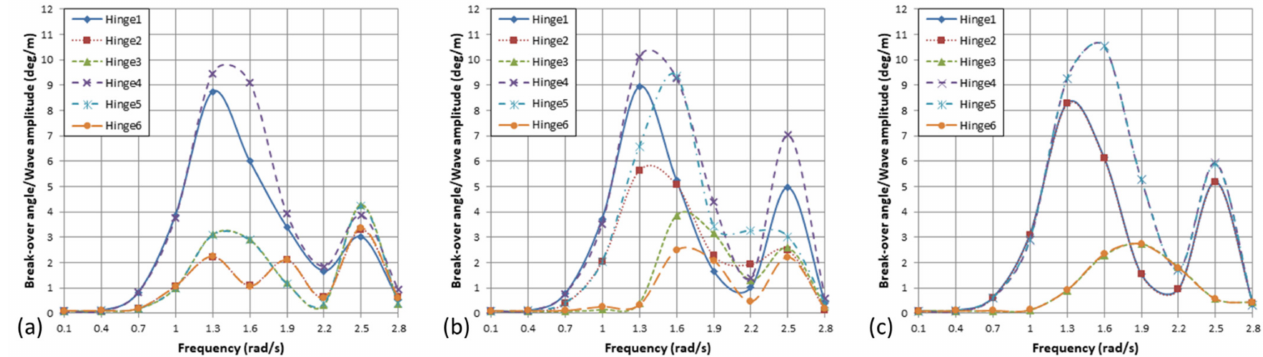
Figure 7. The hinge rotation angle at: ( a ) 0 degrees of incident wave direction; ( b ) 15 degrees of incident wave direction; and ( c ) 30 degrees of incident wave